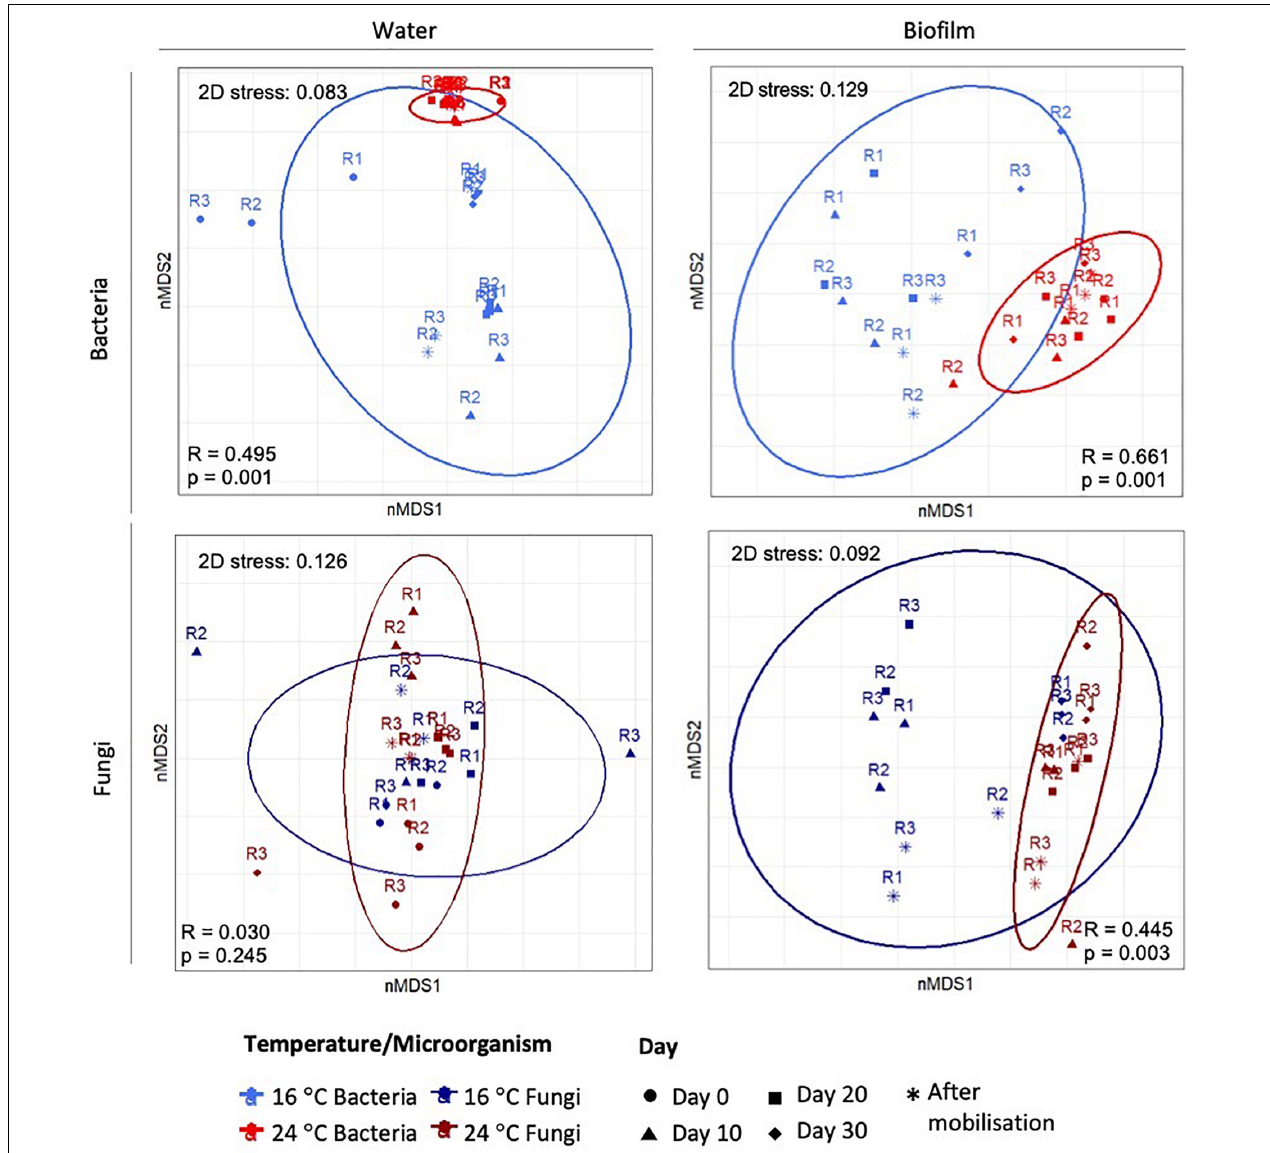
FIGURE 3 | Two-dimensional plot of the non-multidimensional scaling (nMDS) analysis based on Bray–Curtis similarities of the relative abundance of bacteria and fungi in water and biofilm samples. The 3 replicates (R1, R2, and R3) per sampling day are